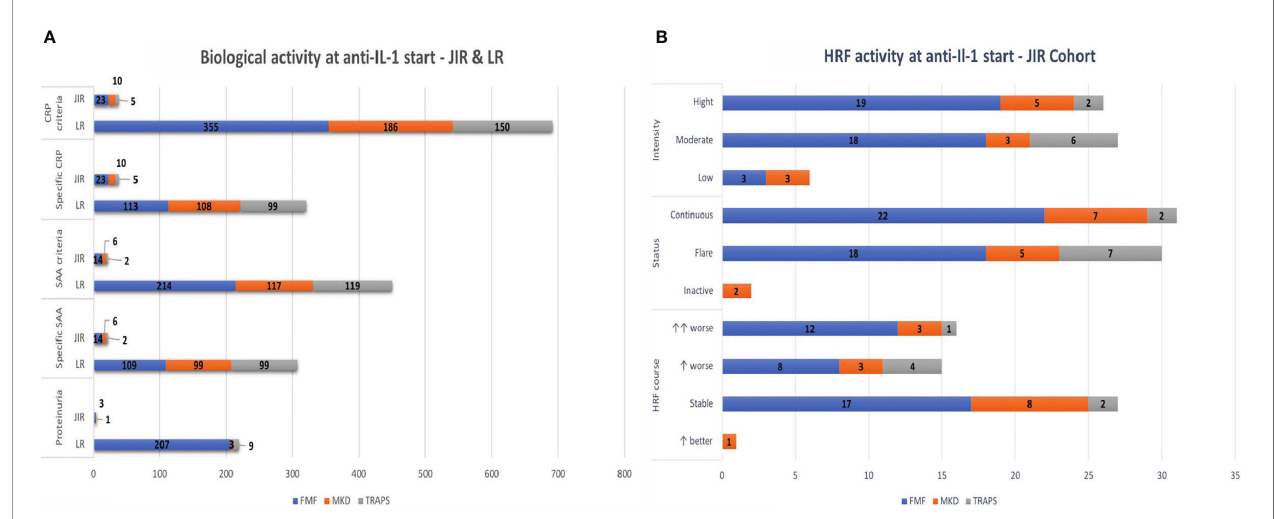
FIGURE 3 | (A) Biological activity at IL-1 inhibitors ’ start. (B) HRF activity at IL-1 inhibitors ’ start. IL, interleukin; HRF, hereditary recurrent fever; FMF, familial Mediterranean fever; MKD, mevalonate kinase de fi ciency; TRAPS, tumor necrosis factor receptor-associated periodic syndrome; LR, literature review; CRP, C-reactive protein; SAA, serum amyloid A